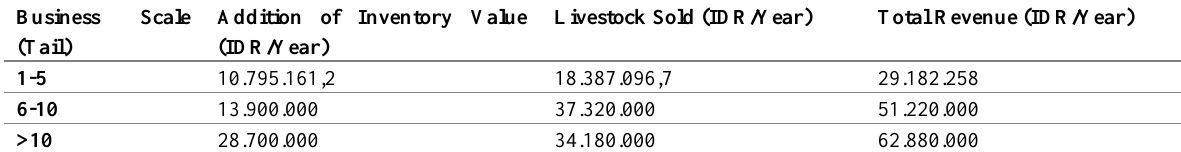
Table 3: Average Income of Bali Cattle Breeders with Different Business